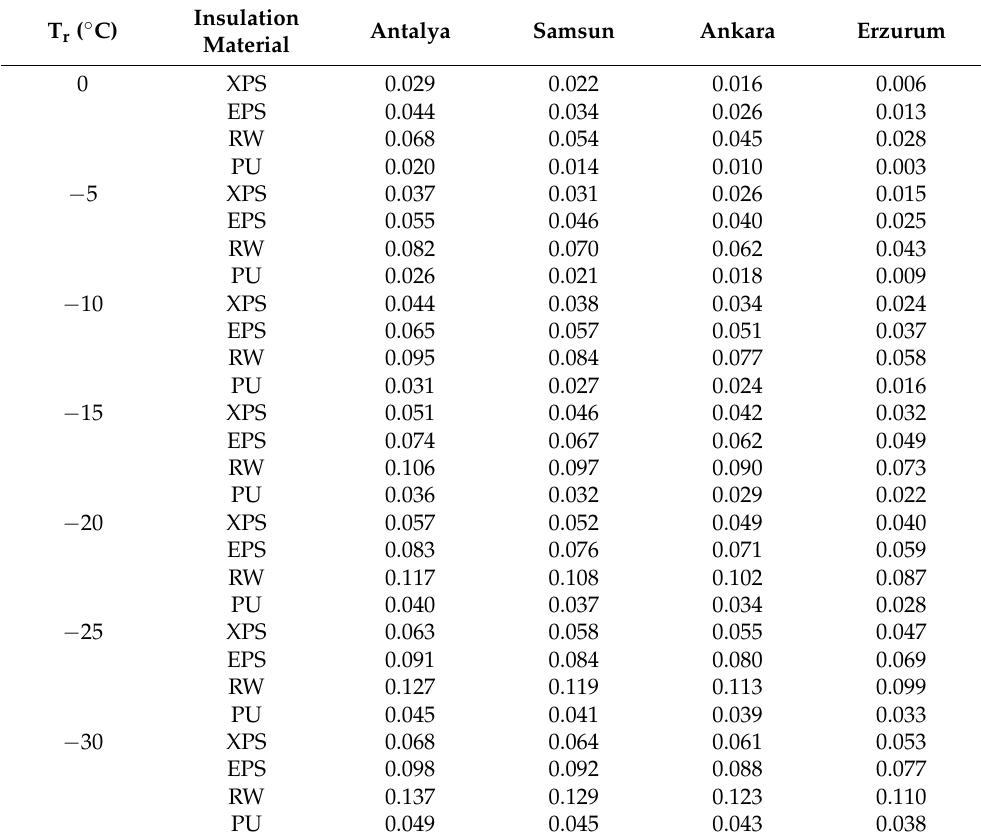
Table 4. Optimum insulation thickness (m) at different reference temperatures of four insulation materials in the selected